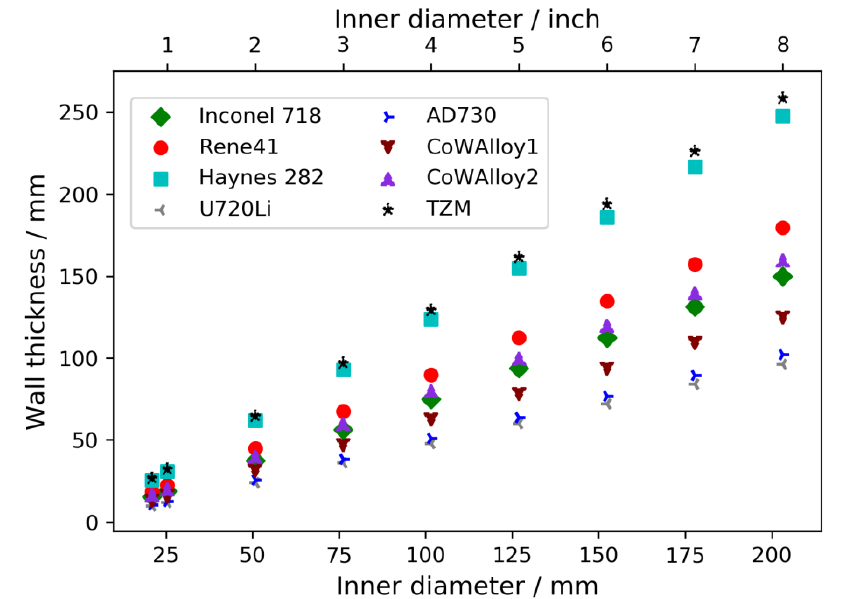
Figure 9. Wall thickness for a maximum operating pressure of 300 MPa estimated using Equation (1), with R p 0.2 of the different alloys at 650 ◦ C and a safety factor of 1.5 (i.e., p = 450 MPa). For better readability of the data for the remaining alloys, the values for Inconel 625 were excluded from the plot because the low mechanical strength would cause dissimilarly large wall thicknesses. The lowest inner diameter was represented by the experimentally studied geometry with 21 mm inner diameter.